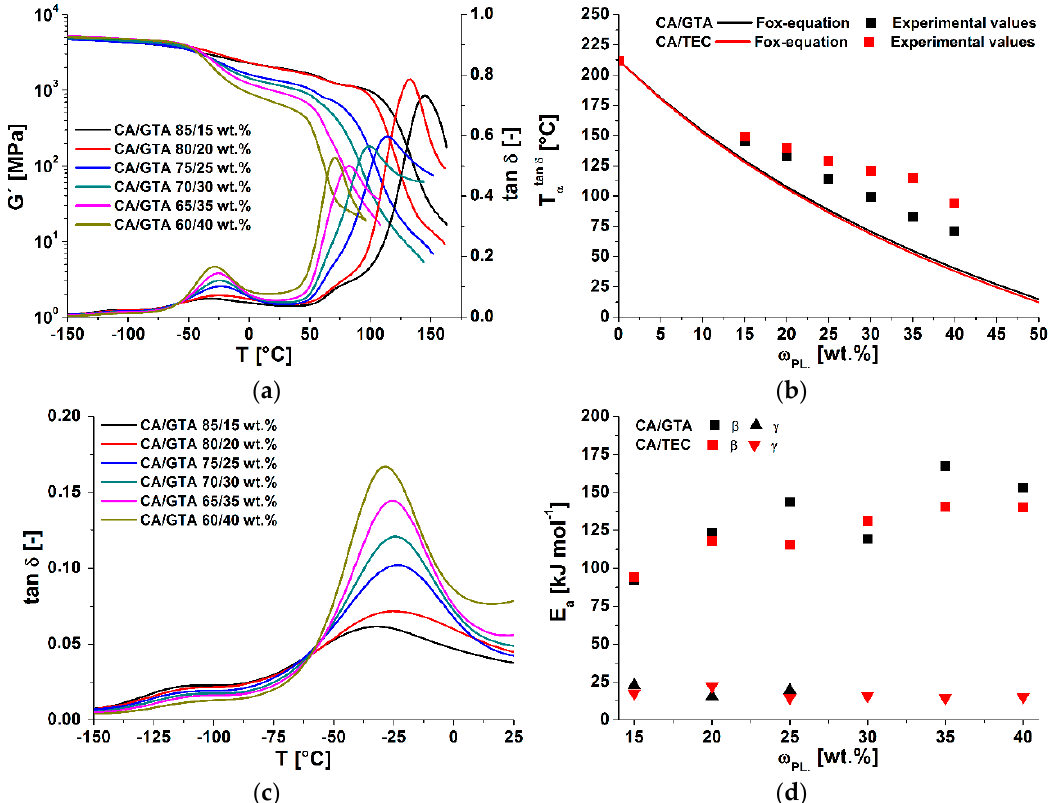
Figure 4. Results of the DMTA measurements of different plasticized cellulose acetate. ( a ) tan δ of GTA and TEC plasticized CA; ( b ) experimental and theoretical values of the α -relaxation temperature; ( c ) tan δ of β - and γ -relaxation temperature; ( d ) activation energies of the β - and γ -relaxation of GTA and TEC plasticized CA.